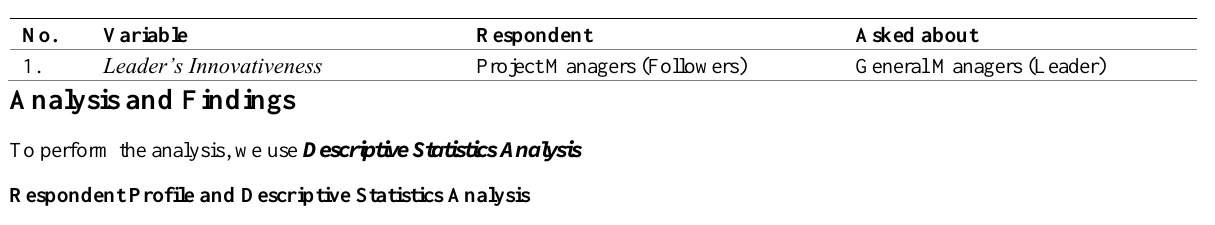
Table 2: Data Collection Scheme